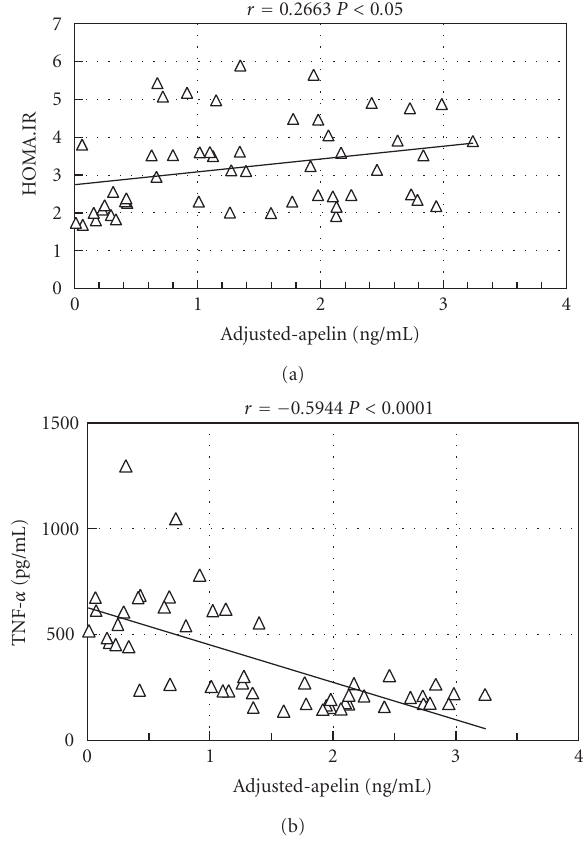
Figure 1: (a) Regression analysis showing correlation between adjusted-apelin and HOMA.IR among CHC patients ( n = 73). (b) Regression analysis showing correlation between adjusted-apelin and TNF- α among CHC patients ( n = 73).